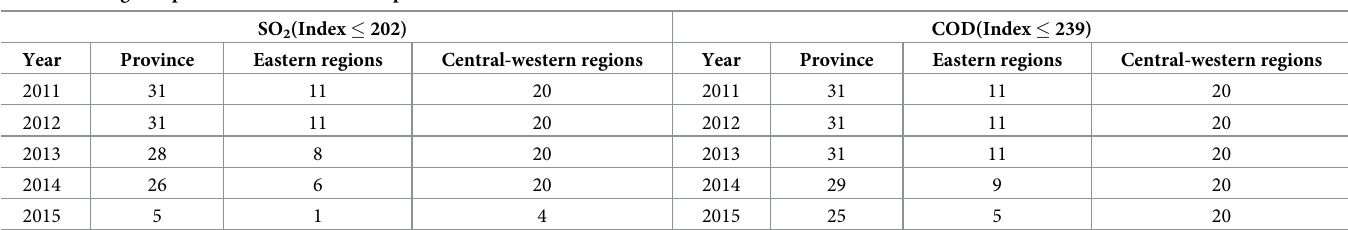
Table 8. Changes in provinces below threshold